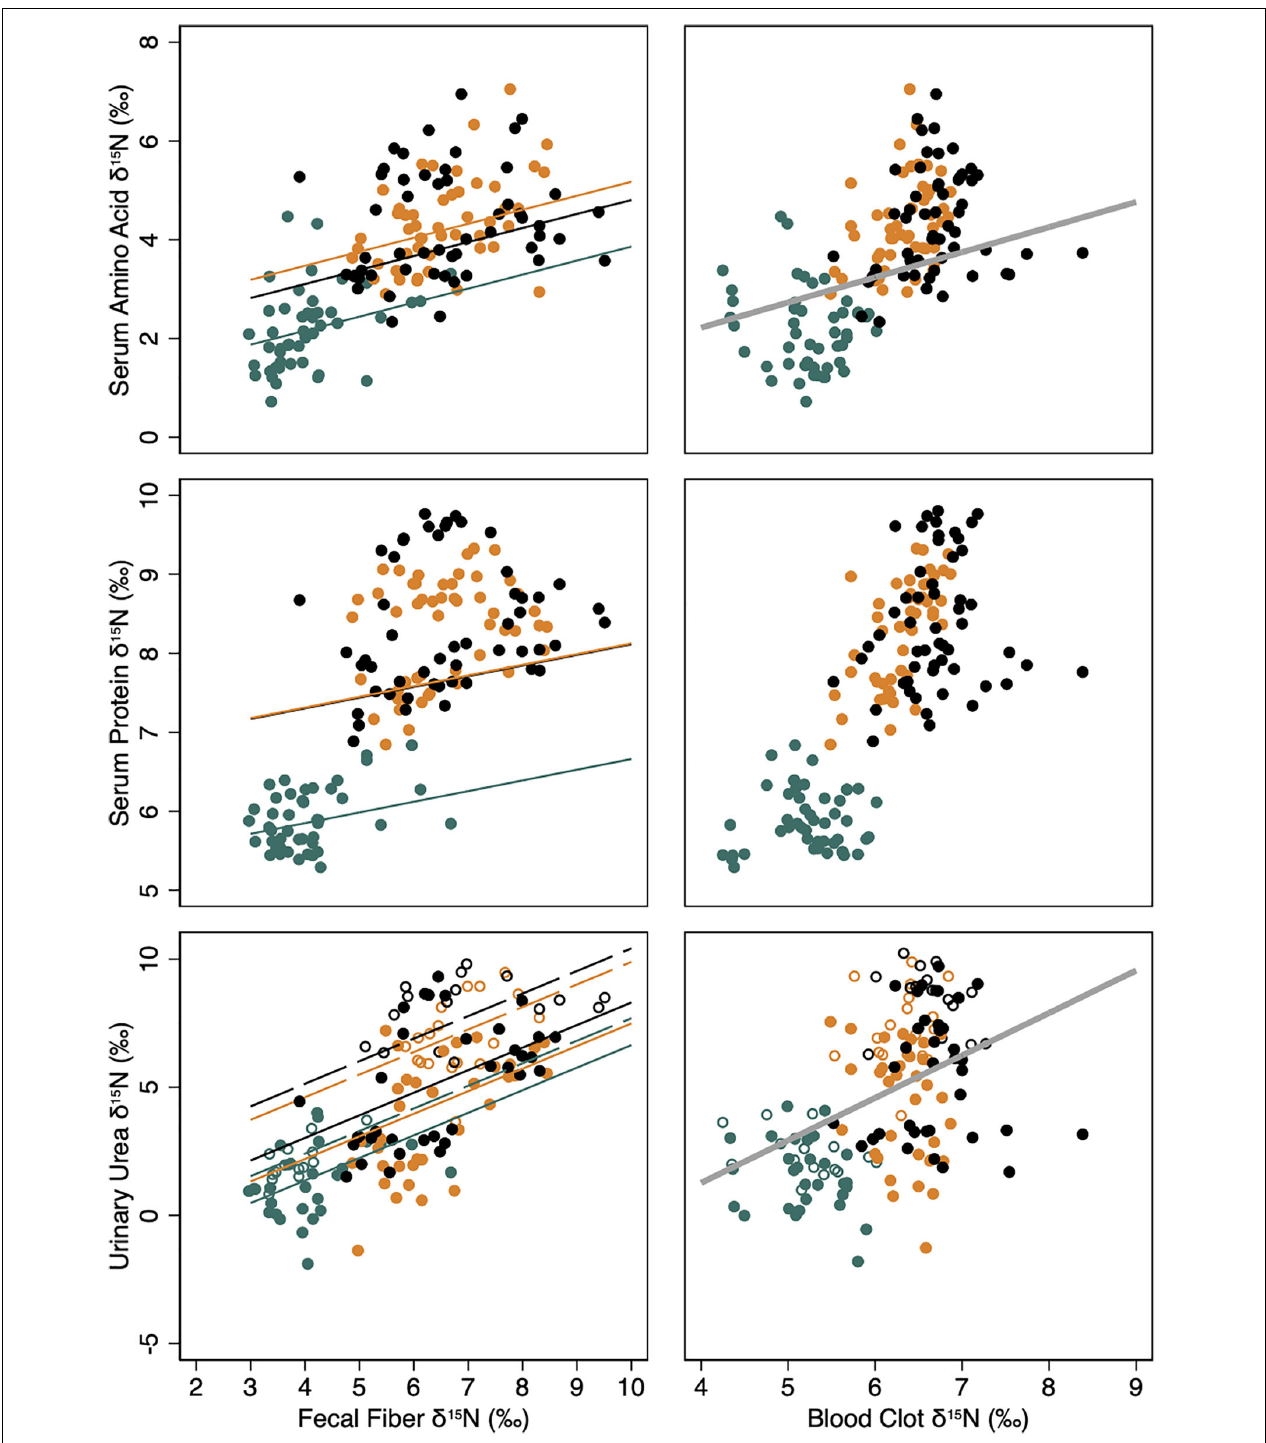
); Y N ] in serum amino acids, serum protein and urinary urea and their relationship to the respective isotopic value of the FIGURE 3 | Isotopic pools of body N [ δ 15 N ( diet, indicated by fecal fiber (left column) or the body protein, indicated by clotted blood cells (right column). Lines indicate predicted linear relationships from mixed (cid:104) model regressions for female reindeer (black), caribou (orange), and muskoxen (green) in late winter from February to April of 2009 in Fairbanks, AK, United States. Solid lines and solid symbols indicate relationships and observations when food was provided ad libitum whereas dashed lines and open symbols indicate relationships and observations when food was restricted. Thick gray lines indicate linear relationships between body N pools and clotted blood cells as a single fixed effect among taxa. All regression models included individual animal (constant) and time (ordinal days; covariate) as random effects to account for repeated measures.